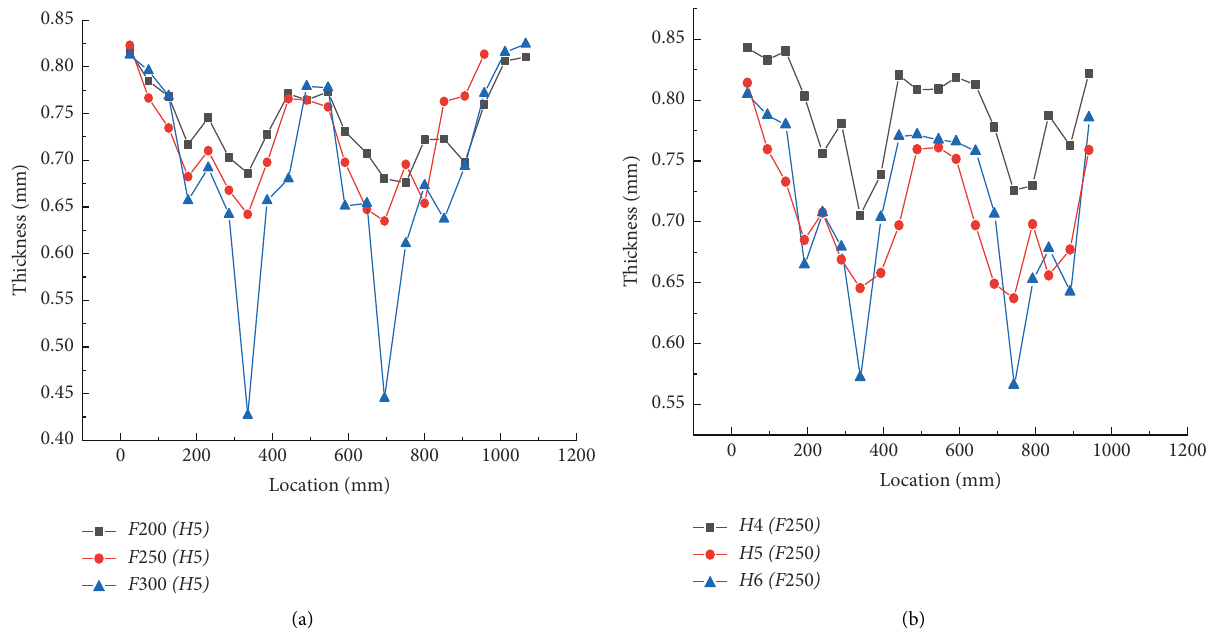
Figure 5: Thickness distribution curve of M section. (a) Draw bead height 5mm. (b) Constant side pressure of 250kN.